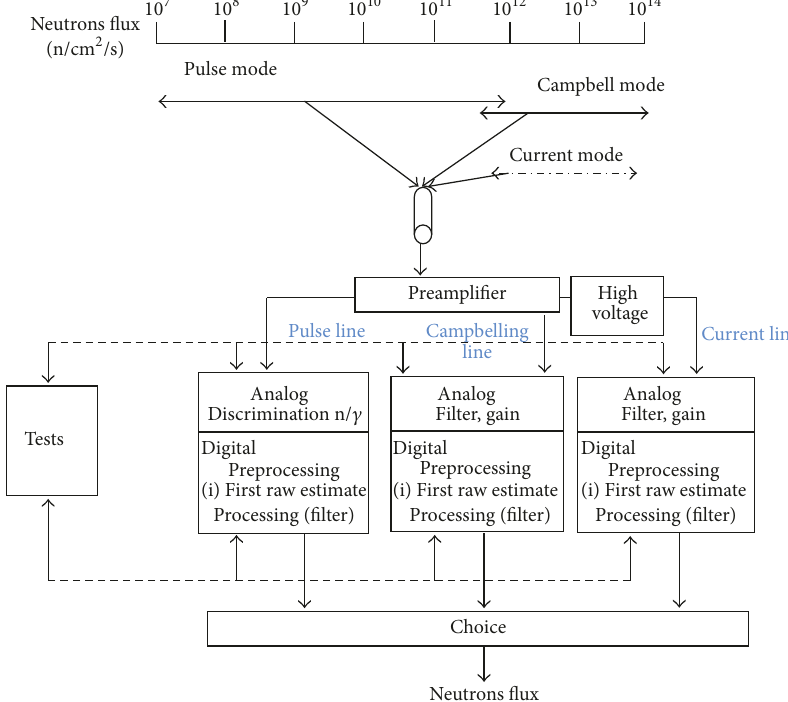
Figure 2: Schematic of the electronic system used in the IRINA project [5].